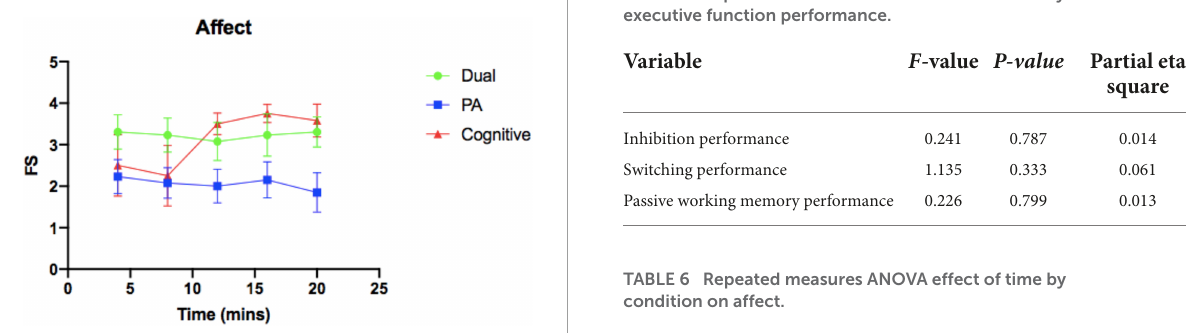
TABLE 5 Repeated measures ANOVA effect of time by condition on executive function performance.